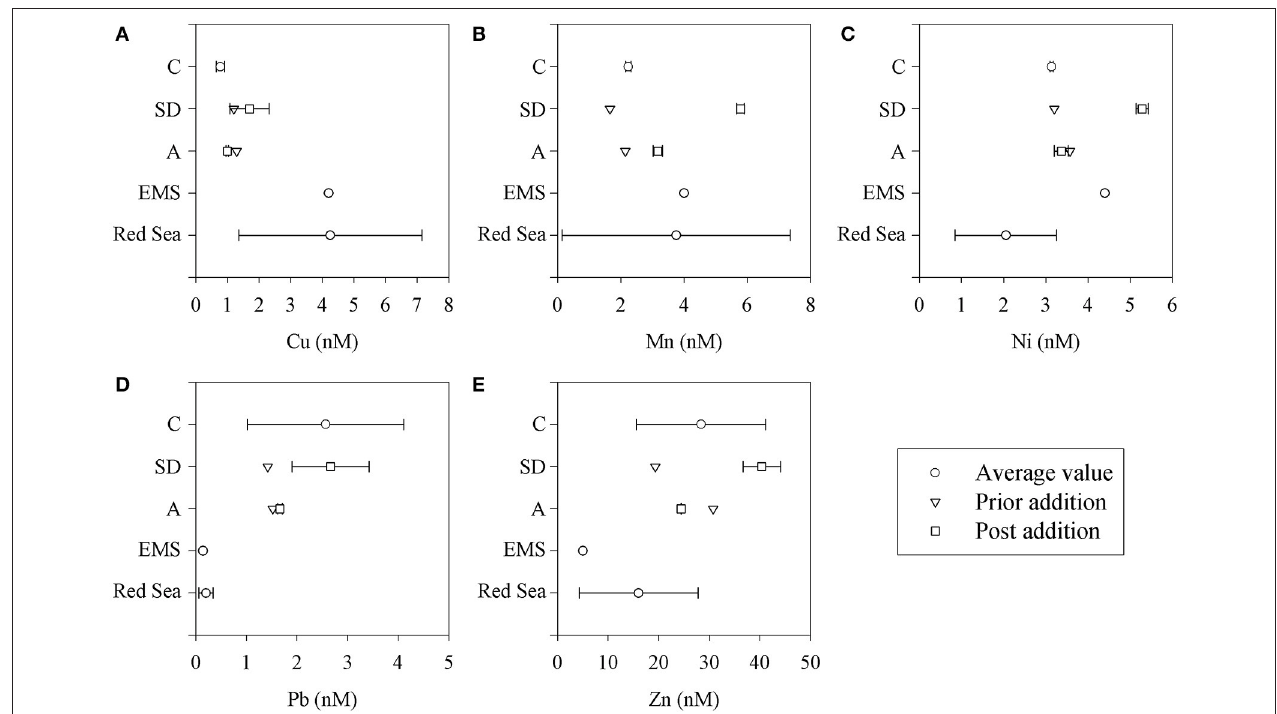
FIGURE 4 | Dissolved trace metal concentrations (A-E) in the mesocosm tanks (C, SD, and A) and in representative oligotrophic stations in the eastern Mediterranean (EMS) and Red (northern Gulf of Aqaba) Seas (Herut et al., unpublished). Values are presented in